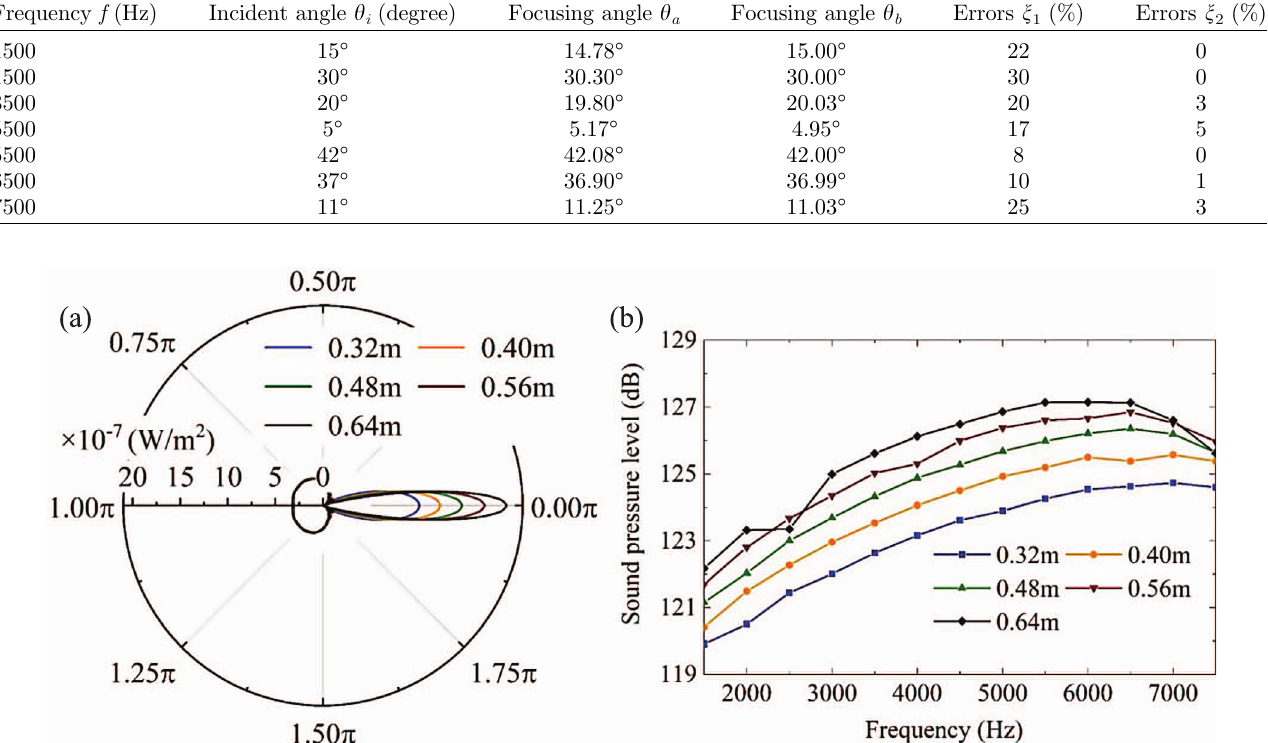
Table 1. Sound propagating direction identi fi cation with rotation correction.